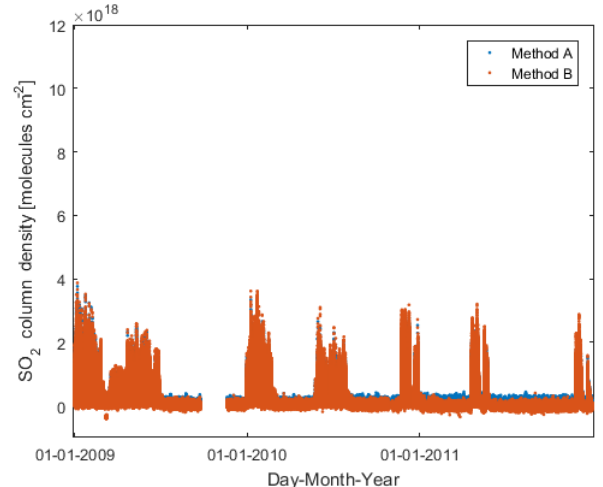
Figure B3. SO 2 CD time series for instrument D2J2140 at Tungu- rahua. The blue dots show a NOVAC-type evaluation while the red dots show the SO 2 CDs from a modelled FRS.